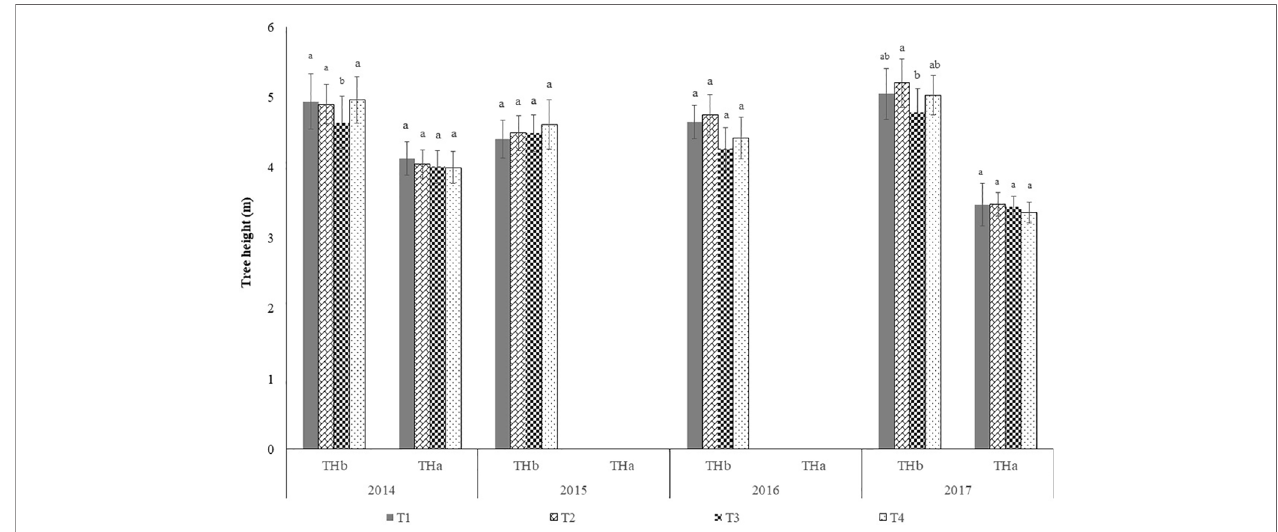
FIGURE 7 | Tree height before and after winter pruning in each year (mean±sd). Legend: THb, tree height before winter pruning; THa, tree height after winter pruning; T1, treatment 1; T2, treatment 2; T3, treatment 3; T4, treatment 4. In each year, before and after pruning, columns followed by the same letter are not signi fi cantly different by Duncan multiple range test at the 5%